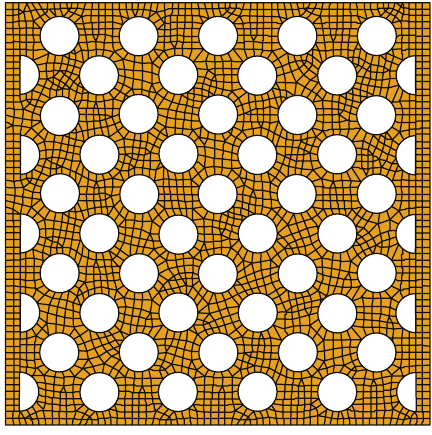
Figure 5: Round hole grids.